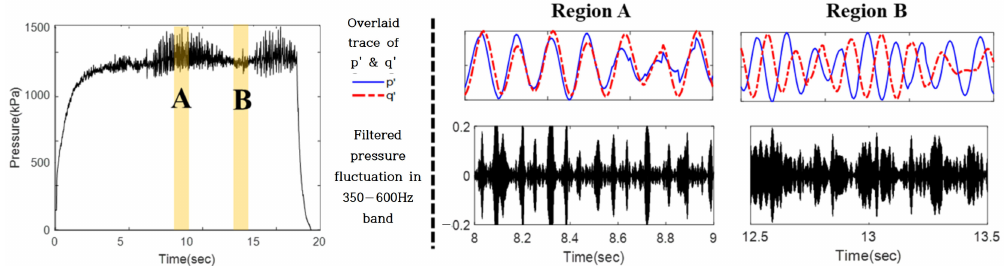
Figure 2. Overlays of p (cid:48) and q (cid:48) ( top row ) in regions A and B ( left ) and filtered from 350 to 600 Hz ( bottom row